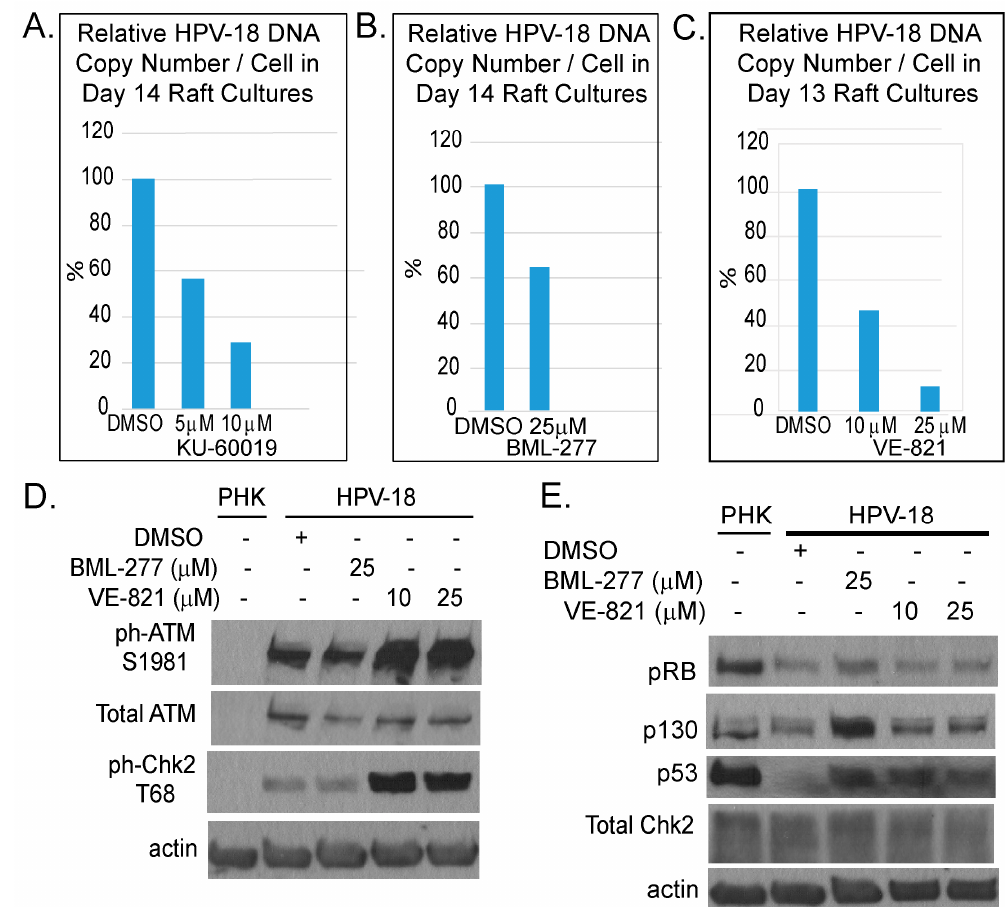
Figure 4. Comparison of inhibitory effects of inhibitors of ATM (KU-60019), Chk2 (BML-277) and ATR (VE-821). ( A – C ) Bar chart depicts relative HPV-18 DNA copy number per cell as determined by real time qPCR of DNA from raft cultures exposed to KU-60019 (days 7–14), BML277 (days 7–14) or VE-821 (days 6–13) and harvested on last days of treatment. ( D,E ) Immunoblot analyses of lysates from untreated PHK raft cultures and from DMSO-, BML-277 or VE-821 treated HPV-18 raft cultures. ( D ) HPV-18 infection activates DDR response relative to uninfected cultures. VE-821-treated HPV-18 raft cultures had elevated ph-ATM S1981 and ph-Chk2 relative to DMSO-treated cultures. ( E ) Treated HPV-18 infected cultures had increased p130 and p53 relative to untreated cultures; but, treatments did not alter total Chk2 protein level. Actin served as loading control in both gels.